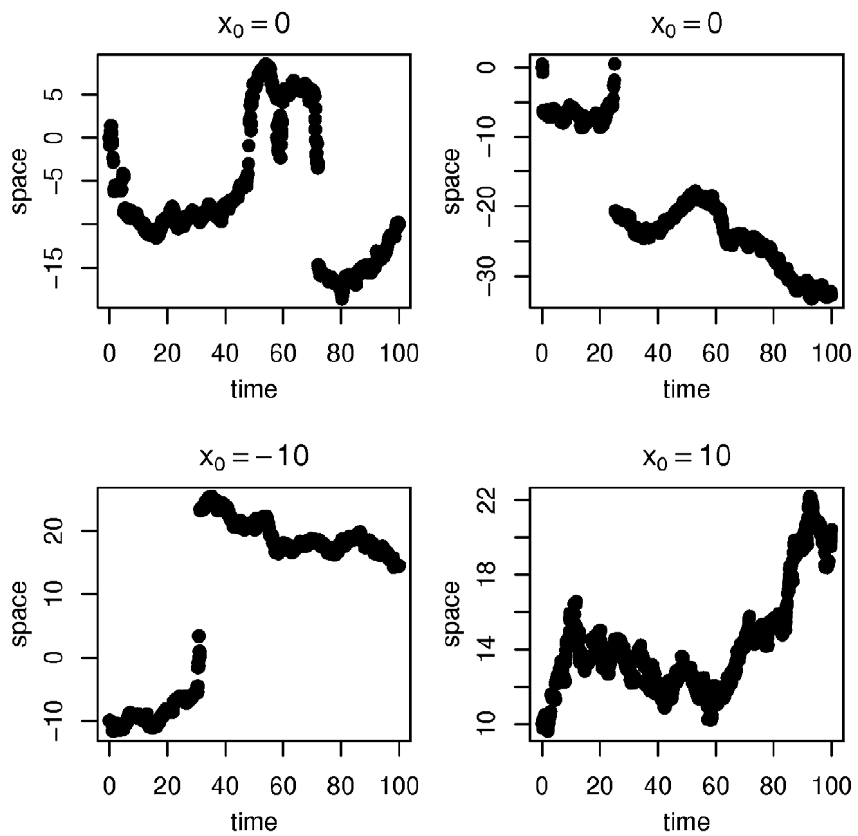
Figure 4. Meixner-like process with a x ð Þ : ~ 1 z 10e { 1 25 { x2 1 { 5 , 5 ð Þ x ð Þ . The process moves with bigger steps around the origin than for larger (and smaller) values. In fact by the choice of x . a ( x ) the rate of the exponential decay of the transition density is reduced around the origin.